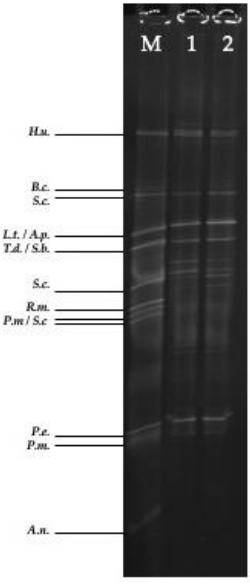
Figure 2. DGGE analysis of amplified 26S rRNA gene (PCR) products obtained from DNA extracted from the grape washing solutions after the treatment (Lane 1 and 2 are replicates). M: molecular marker prepared by loading the DNA from individual species into a single lane, containing: Hanseniaspora uvarum DESP52 ( H.u. ); Botrytis cinerea B2 ( B.c.) ; S. cerevisiae EC1118 ( S.c. ); Lachancea thermotolerans COLC27 ( L.t. ); Aureobasidium pullulans A1 ( A.p. ); Torulaspora delbrueckii PINOTG5 ( T.d. ); Starmerella bacillaris MALV45 ( S.b. ); Rhodotorula mucilaginosa CLINT2 ( R.m. ); Pichia membranifaciens COLBR1 ( P.m. ); Penicillium expansum VSA ( P.e. ); Aspergillus niger VSE ( A.n. ). Note: it was not possible to unequivocally distinguish between L. thermotolerans and A. pullulans ( L.t. / A.p. ) and between T. delbrueckii and S. bacillaris ( T.d./S.b. ), due to the overlapping of bands from the reference strains in the marker. As for chemical composition, an increase of 1.41 ± 0.21 mg/L of copper and 64.93